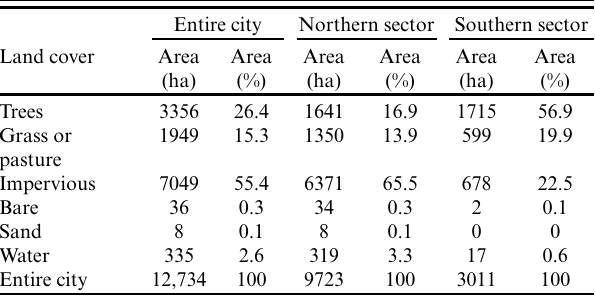
Table 2. Land cover area for the municipality of San Juan, Puerto Rico, in 2002.